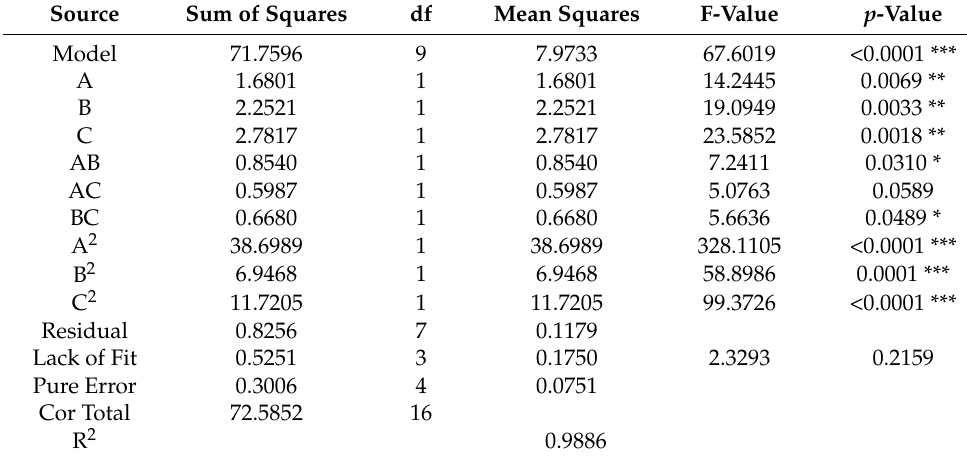
Table 2. Variance analysis of Box–Behnken regression model